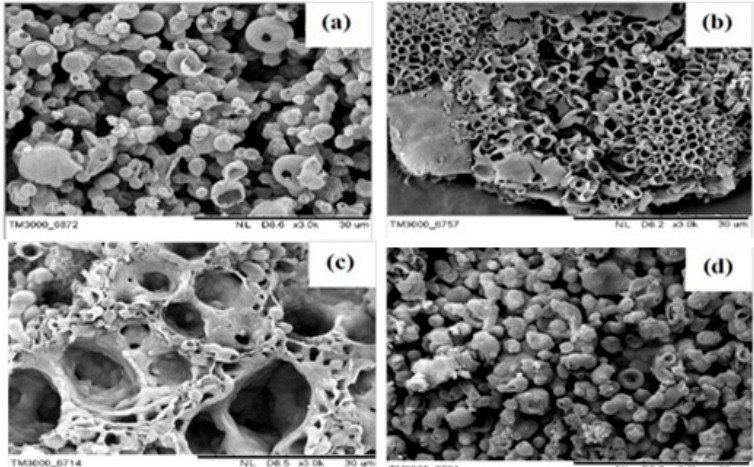
Figure 6. SEM images of the different PCz synthesized with different surfactant type: ( a ) PCz; ( b ) PCz/TW20; ( c ) PCz/CTAB; and ( d ) PCz/SDS at 24h. Reprinted with permission from Sangwan et al. [99]. Copyright (2016) Wiley. The scale bar is 30 μ m.